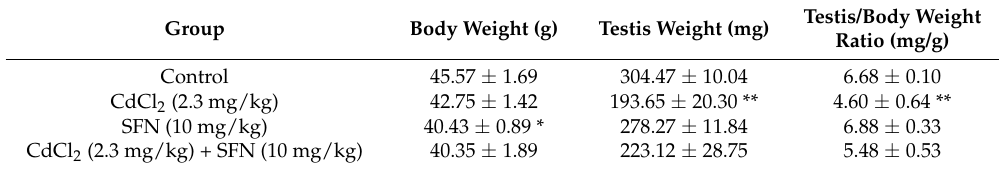
Table 1. Effects of sulforaphane (SFN) on mice body and testis weights and testis/body weight ratio following cadmium